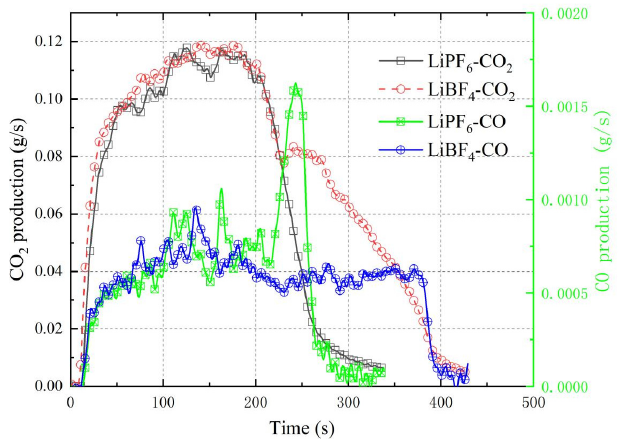
Figure 12. CO and CO 2 production of electrolyte with LiPF 6 or LiBF 4 in Hefei.